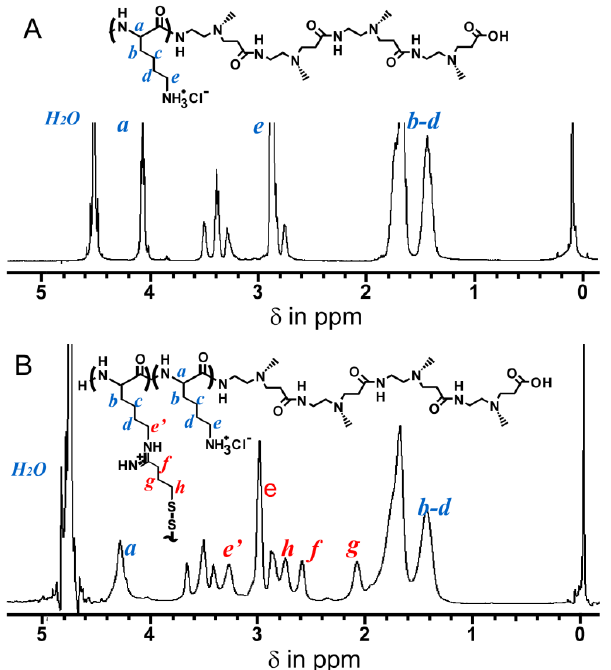
Figure 3. 1 H-NMR spectra of PAMAM dendron-PLL before ( A ) and after ( B ) reaction